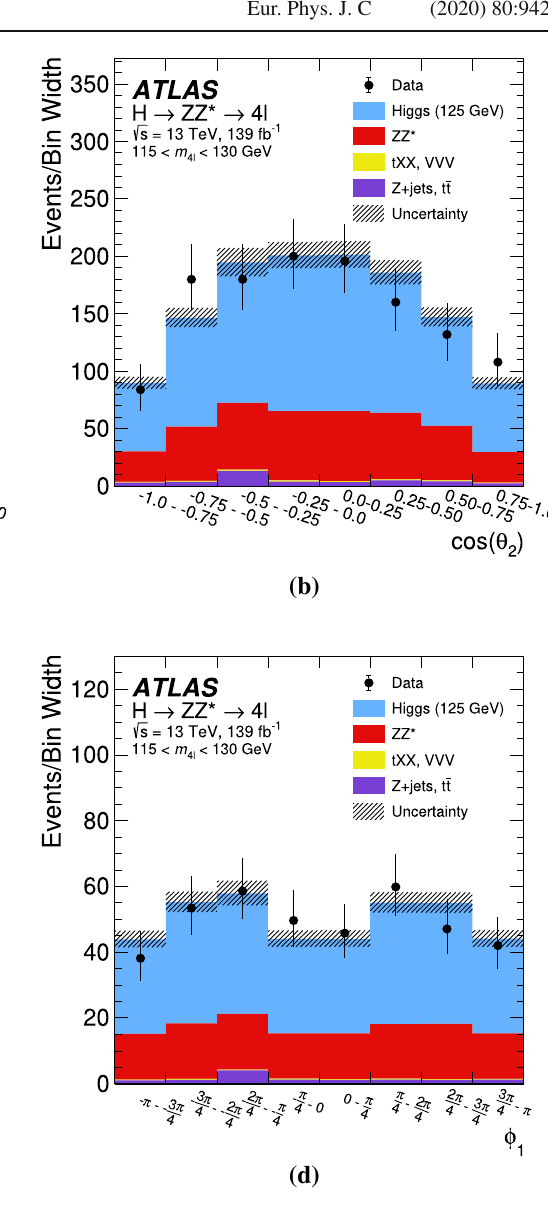
Fig. 6 The observed and expected (pre-fit) distributions of a cos θ 1 , b tainty in the prediction is shown by the hatched band, which includes cos θ 2 , c φ , and d φ 1 in the mass region 115 < m 4 (cid:3) < 130 GeV, for the theoretical uncertainties of the SM cross section for the signal √ an integrated luminosity of 139 fb − 1 collected at s = 13 TeV. A SM Higgs boson signal with a mass m H = 125 GeV is assumed. The uncer-